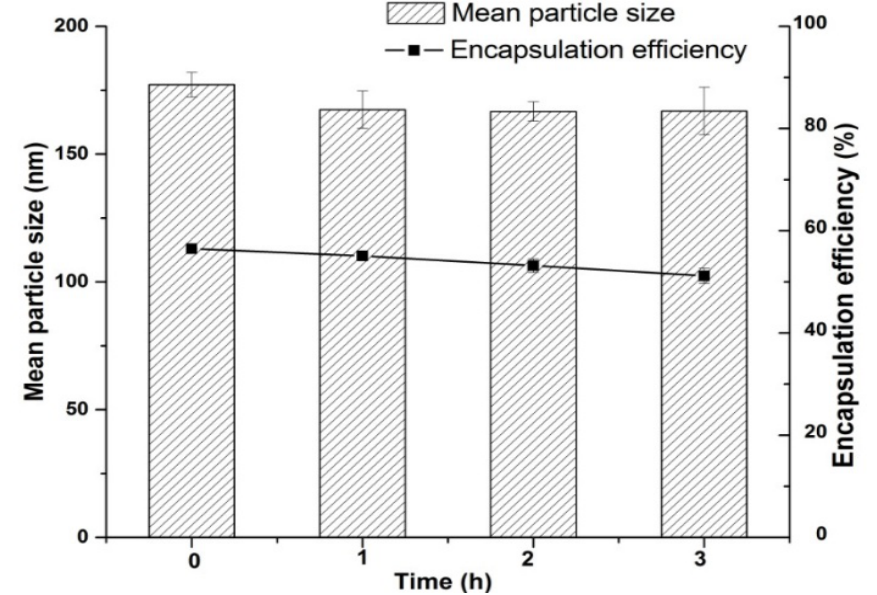
Figure 5. Stability study of optimized TP-SLN in simulated gastric fluid. Results are expressed as mean ± SD (n =